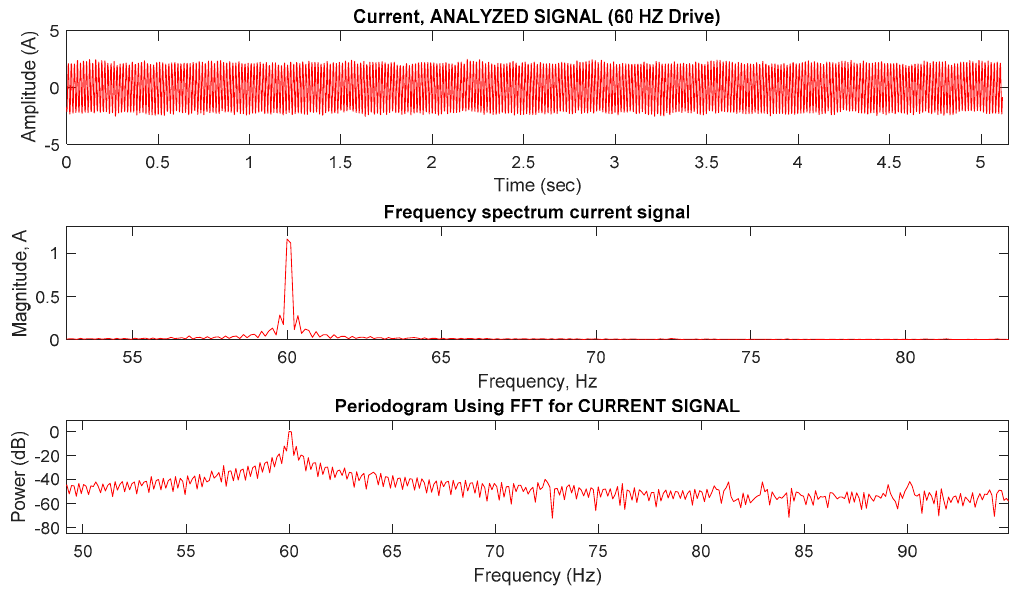
Figure 8. FFT analysis of current signal measurement of motor line current of phase A, frequency spectrum, and periodogram at 60 Hz speed operation.